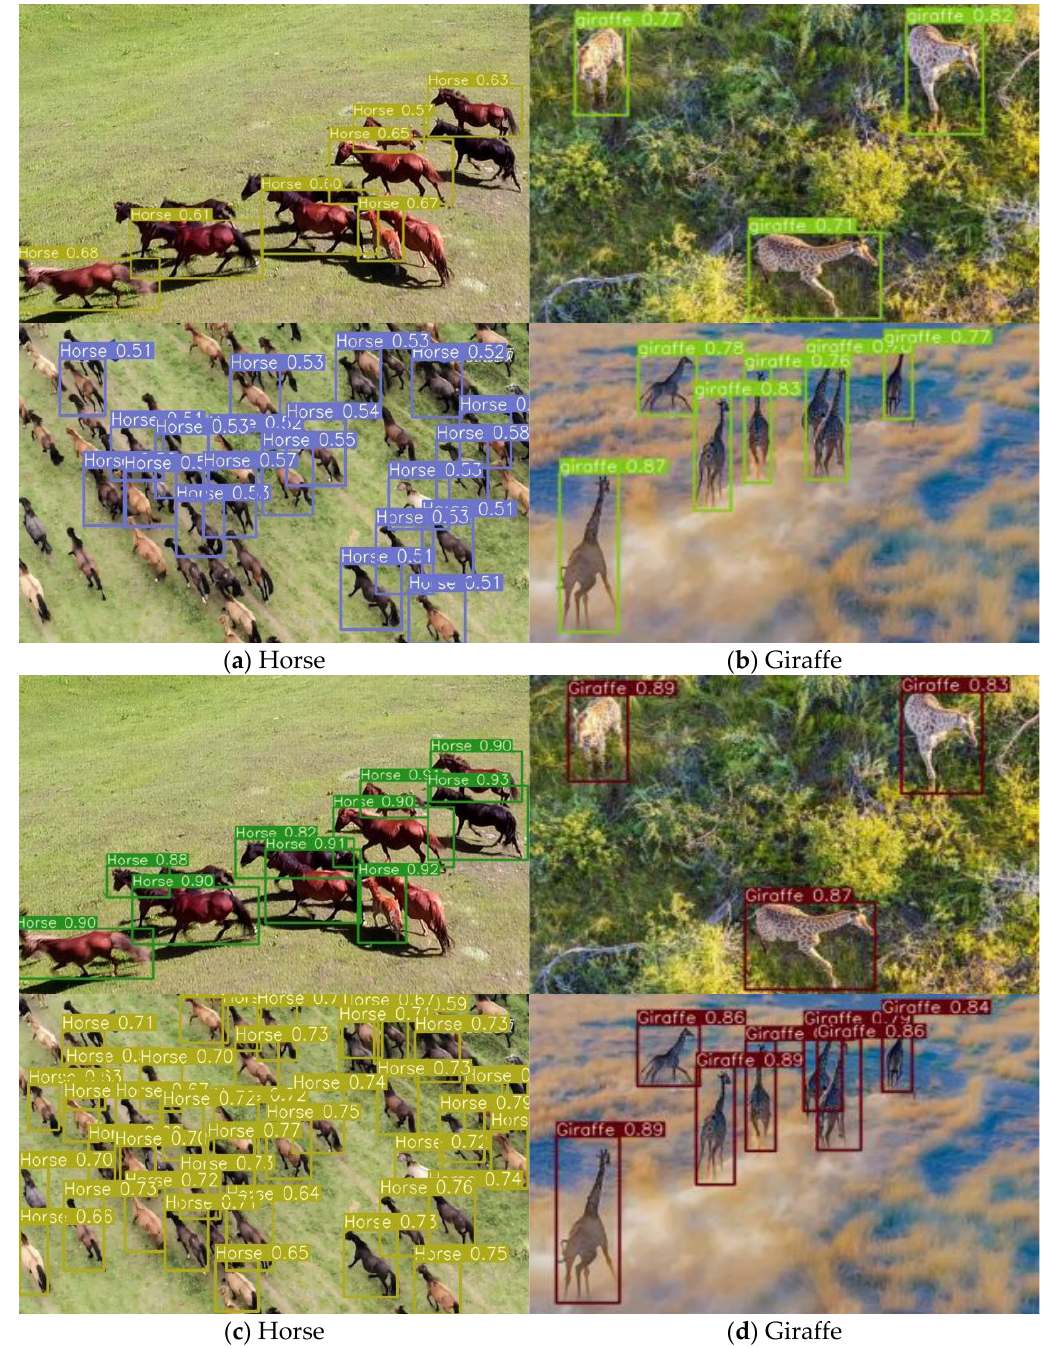
Figure 13. ( a ) Test results for horse with the original YOLOv5s model; ( b ) test results for giraffe with the original YOLOv5s model; ( c ) test results for horse with the improved YOLOv5s model; ( d ) test results for giraffe with the improved YOLOv5s model.